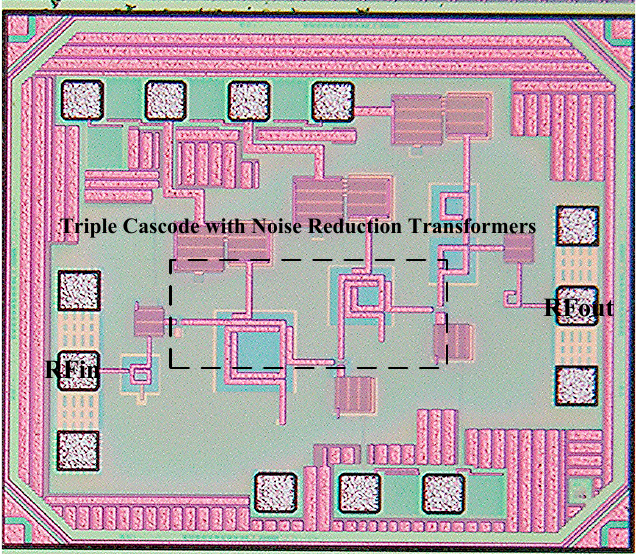
Figure 3. Chip photograph of the V-band magnetic coupled triple-cascode LNA with a size of 0.6 × 0.48 mm 2 including all testing pads